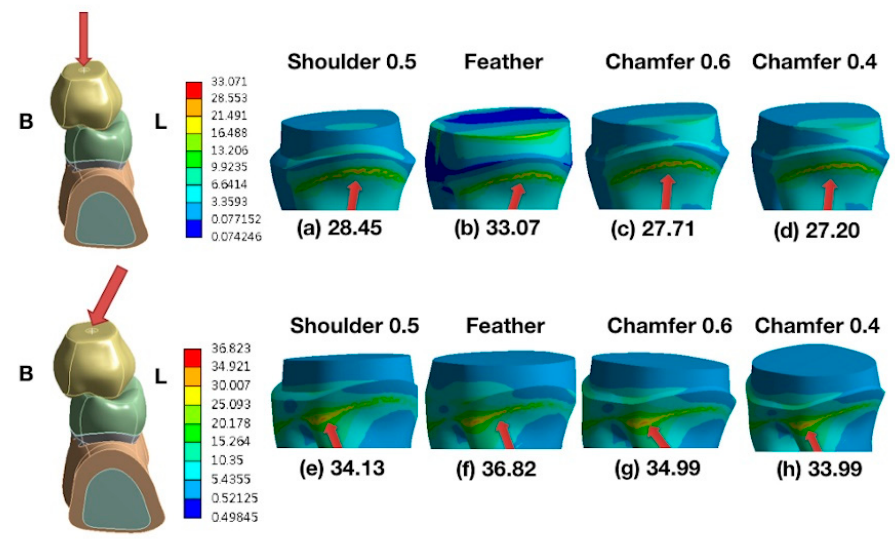
Figure 3. Distributions of stresses on primary molars covered with glass-ceramic crowns. (Top) A vertical load of 200 N applied to the lower, primary second molars. From left to right, the loading models are as follows: ( a ) shoulder (0.5 mm), ( b ) feather-edged, ( c ) chamfer (0.6 mm), and ( d ) mini chamfer (0.4 mm). (Bottom) The oblique 15° load of 200 N applied to the lower, primary second molars. From left to right, the loading models are as follows: ( e ) shoulder (0.5 mm), ( f ) feather-edged, ( g ) chamfer (0.6 mm), and ( h ) mini chamfer (0.4 mm). The red arrows indicate the peak stresses and locations. B—buccal; L—lingual.